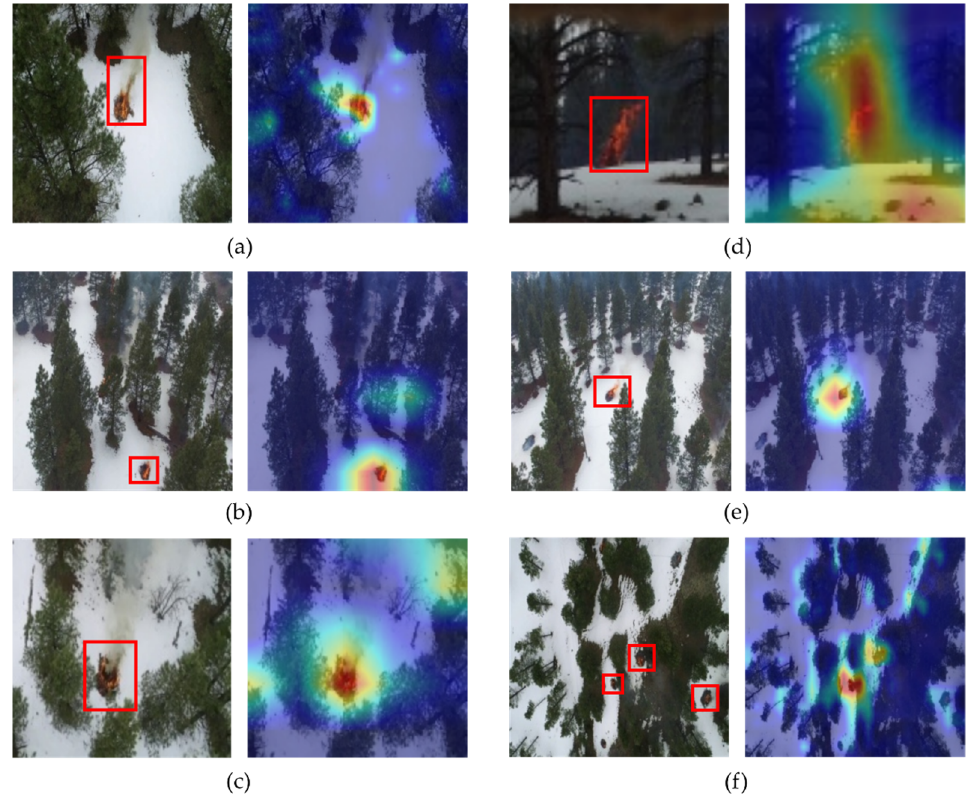
Figure 7. Grad-CAM visualization results on DSA-ResNet50. ( a – f ) show the different testing images and their corresponding Grad-CAM results, with the important regions highlighted in red.